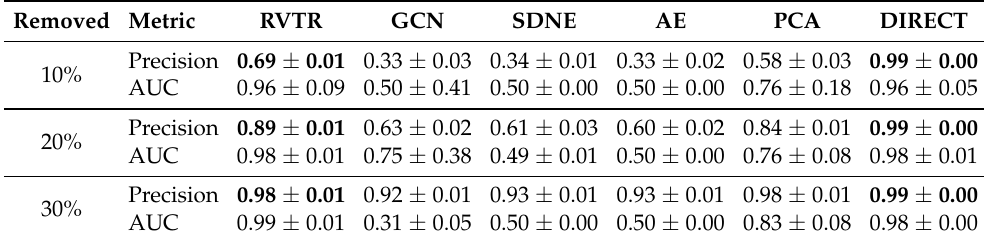
Table 4. The prediction results by different methods tested on the network of 3000. The tests were performed on 10%, 20% and 30% nodes removed, respectively.